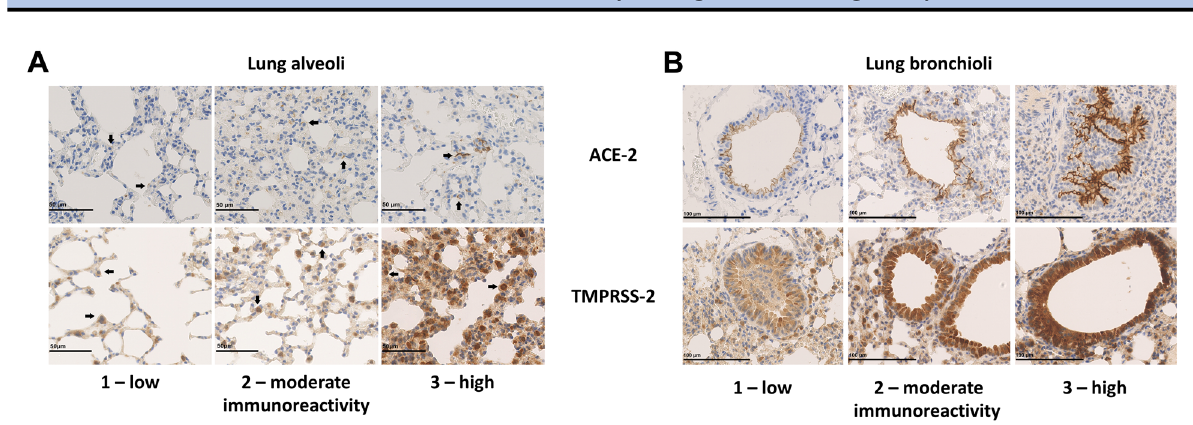
Figure 1. Scoring examples of ACE-2 (upper row) and TMPRSS-2 (lower row) in lung alveoli ( A ) and lung bronchioli ( B ). From left to right: Score = 1 (low immunoreactivity), score = 2 (moderate immunoreactivity), score = 3 (high immunoreactivity). Only membranous staining was evaluated. ACE-2, angiotensin-converting enzyme 2; TMPRSS-2, transmembrane protease serine